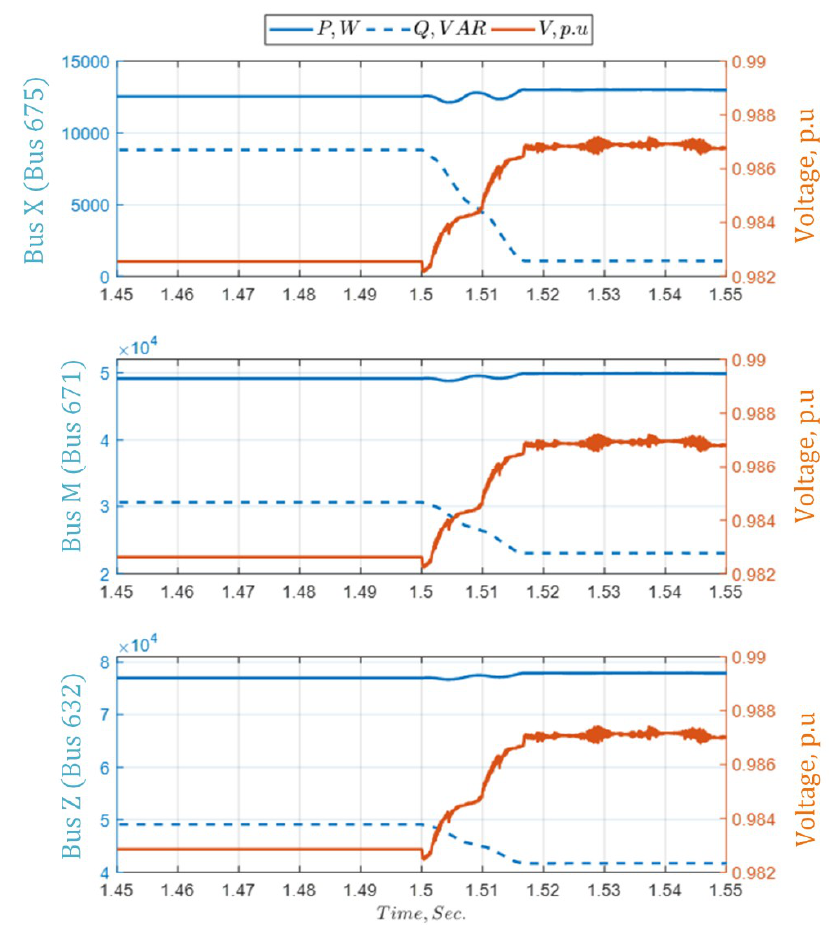
Figure 3. A comparison between the active, reactive power, and the per unit (p.u.) voltage at buses X, M, and Z, respectively.